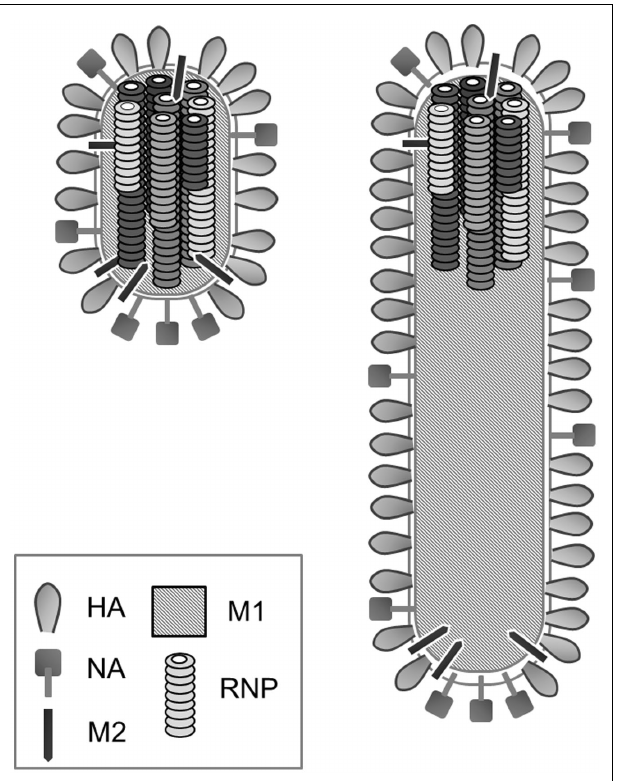
FIGURE 2 | Schematic diagram of influenza virions. Left, an elliptical virion; right, a filamentous virion. Note that both virions contain an organized set of eight RNPs at the end of the